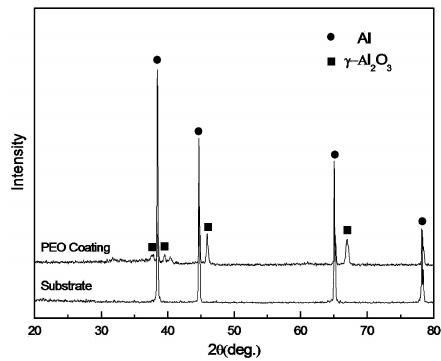
Figure 6. XRD pattern of the Al foams substrate and PEO coating.